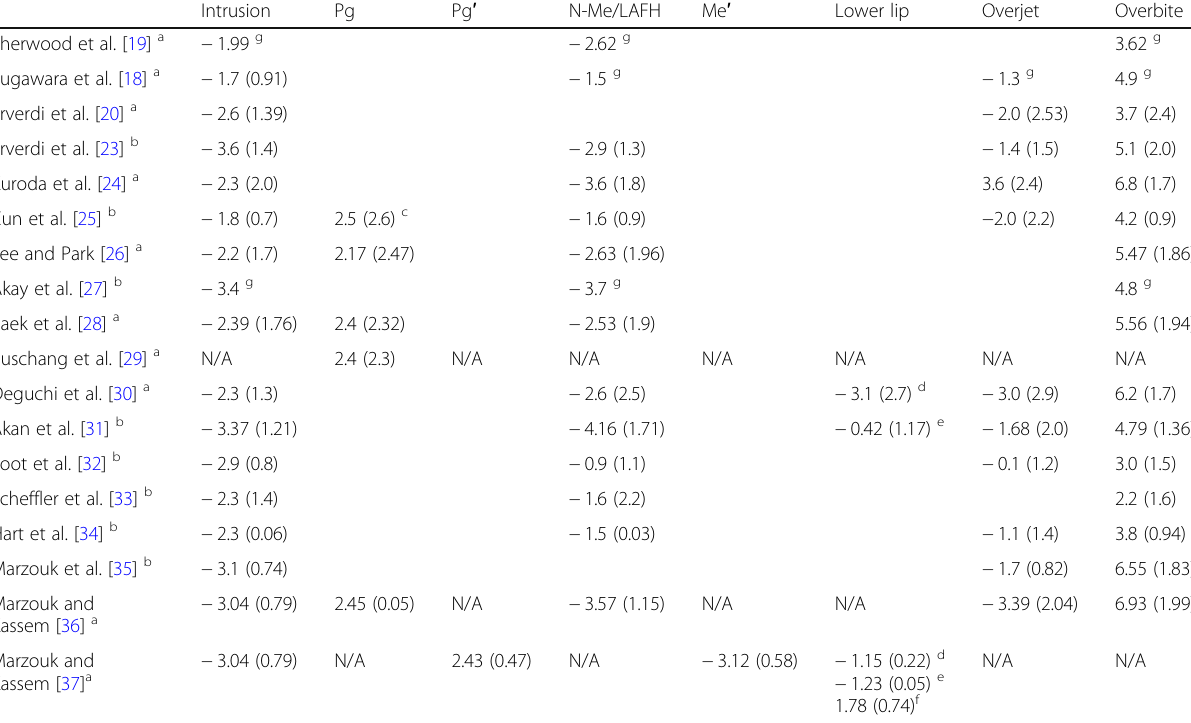
Table 1 Selected variables from studies of molar